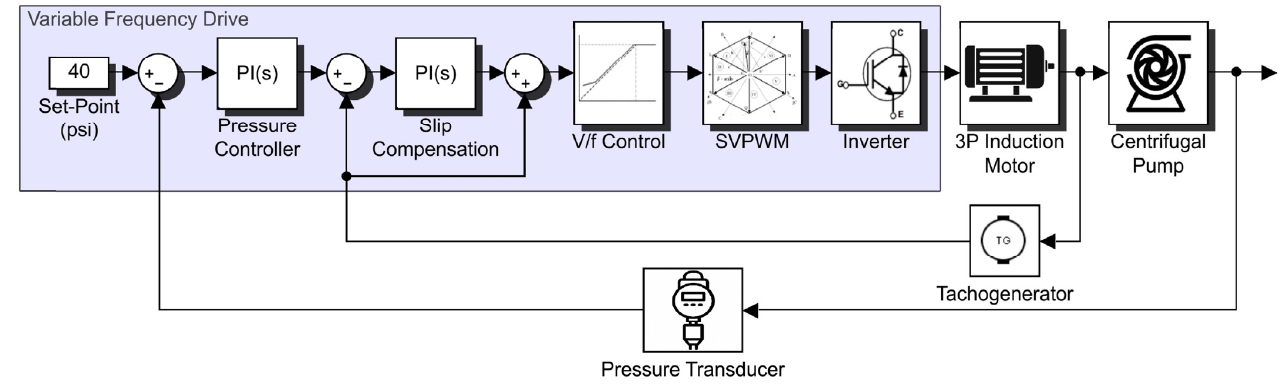
Figure 11. Block diagram of the pumping process control